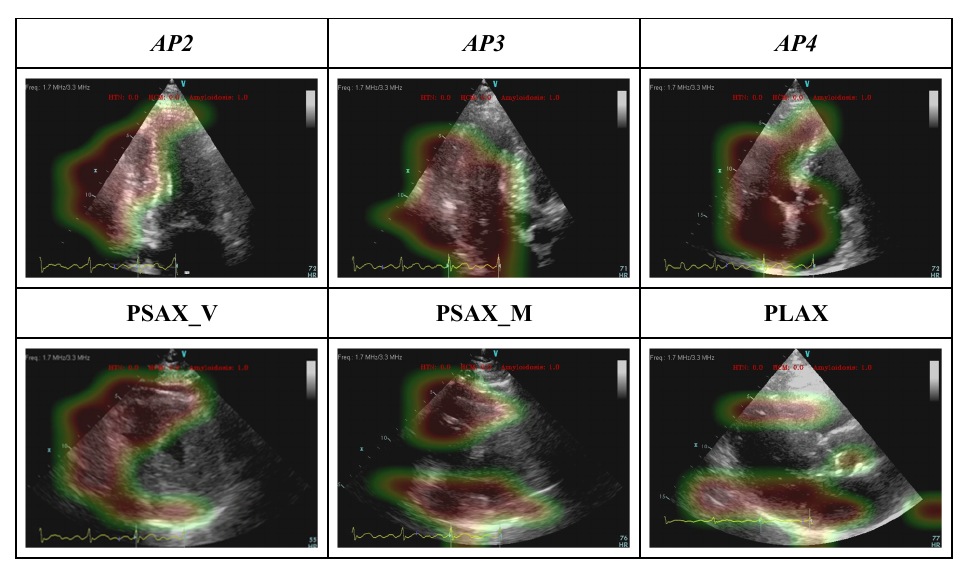
Figure 4. GRADCAM represents the interpretability of the view-dependent model.